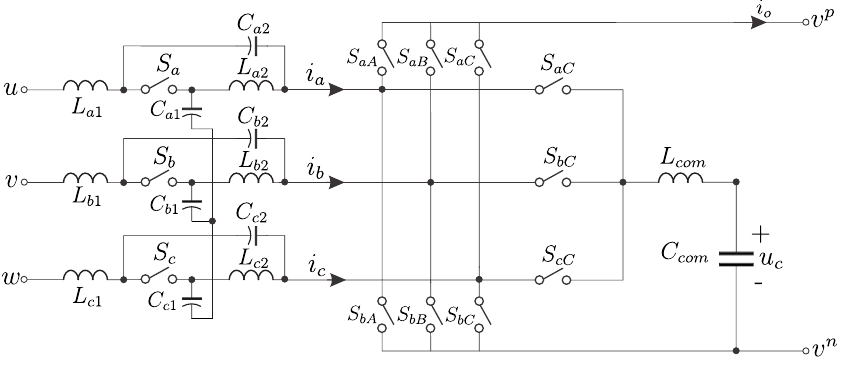
Figure 18. qZSMC